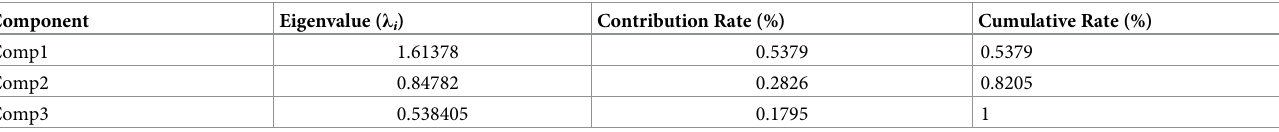
Table 2. PCA results based on three types of pollutant emission